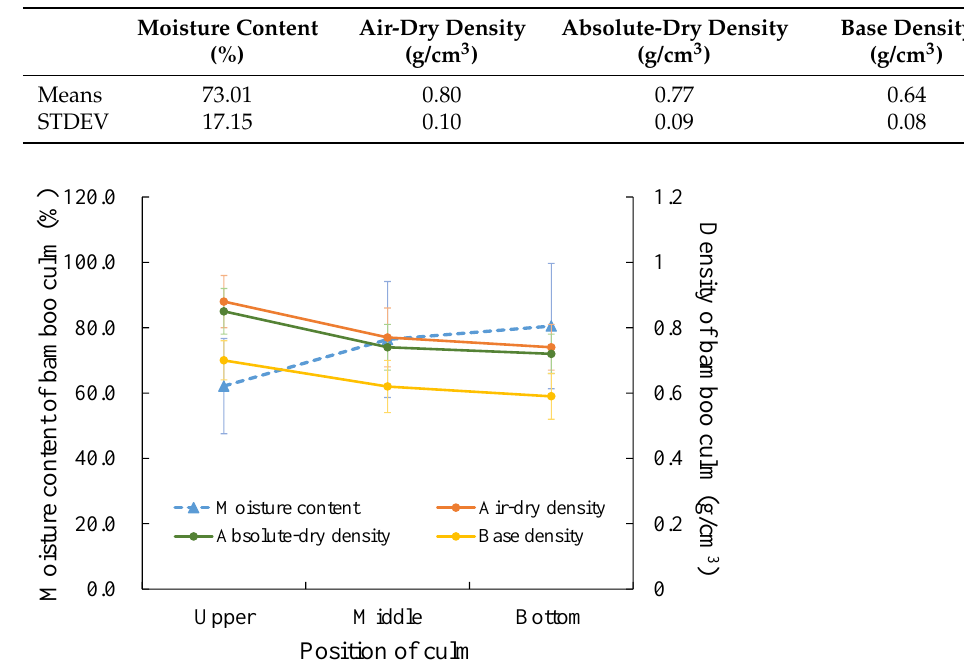
Table 2. Chemical composition of T. oliveri.